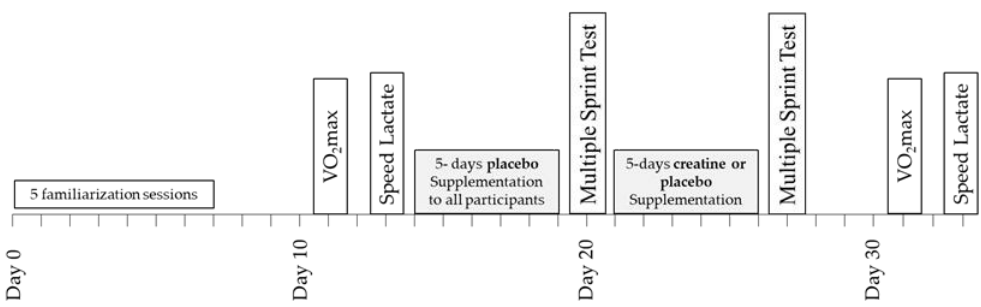
Figure 1. Schematic representation of the experimental design of the study.